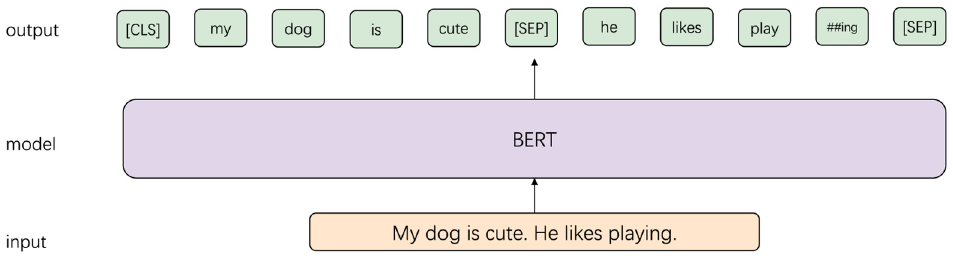
Figure 2. Embedding Generation Flow of